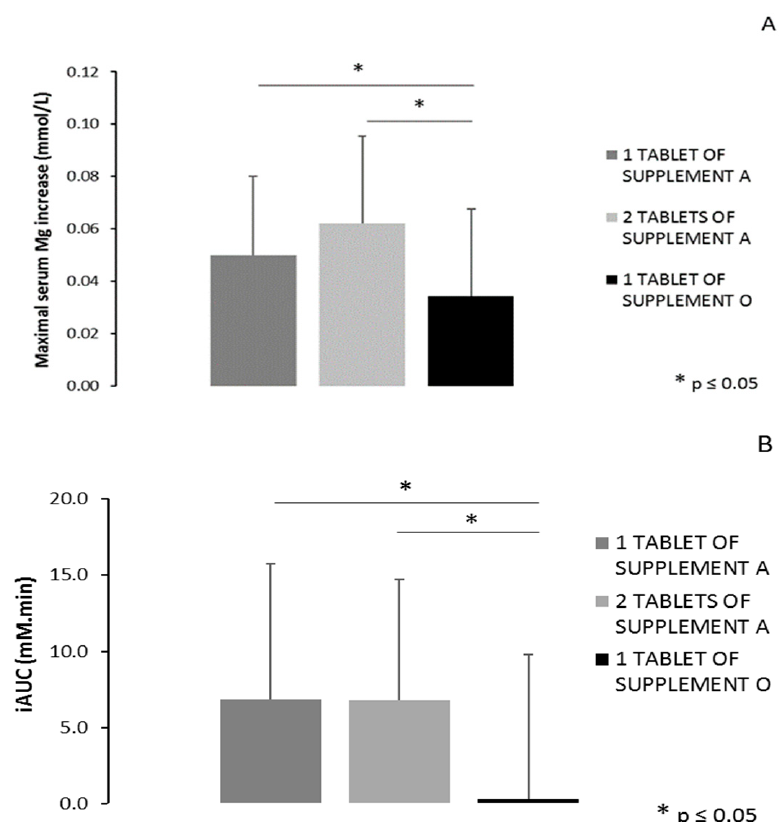
Figure 7. ( A ) The difference in serum magnesium concentration between the peak value and the concentration before ingestion of one or two tablets of Supplement A vs. one tablet of Supplement O (* p = 0.048 for one tablet of Supplement A vs. Supplement O and p = 0.001 for two tablets of Supplement A vs. Supplement O). ( B ) The incremental area under the curve (iAUC) of the serum magnesium concentration starting from ingestion of the supplement up to six hours after ingestion (* p = 0.009 for one tablet of Supplement A vs. Supplement O and p = 0.011 for two tablets of Supplement A vs. Supplement O). * p ≤ 0.05